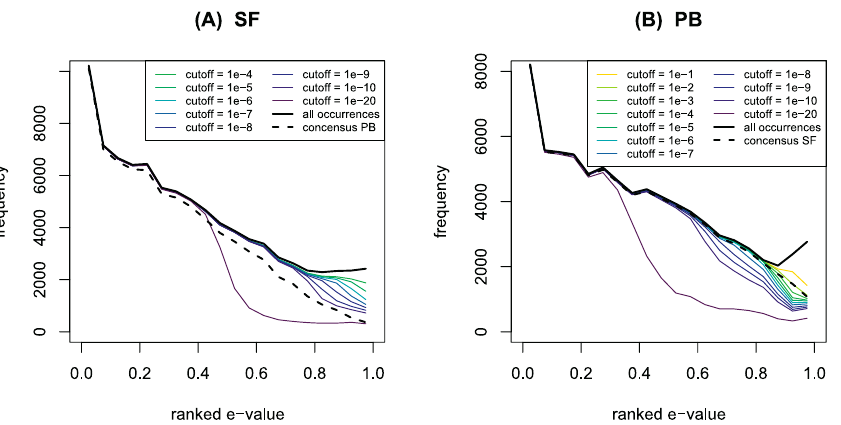
Figure 5. Ranked e-Value Distributions for Occurrences without Isolated Occurrences The predicted false positives are calculated through a base pattern created from assignments with an e-value below the threshold. If an occurrence lies on a genome with either a gain at leaf level in the base pattern or a potential gain at leaf level, it is here defined as an isolated occurrence. A clear overprediction of isolated occurrences is only seen in the set with a base pattern cutoff of 10 (cid:2) 20 .